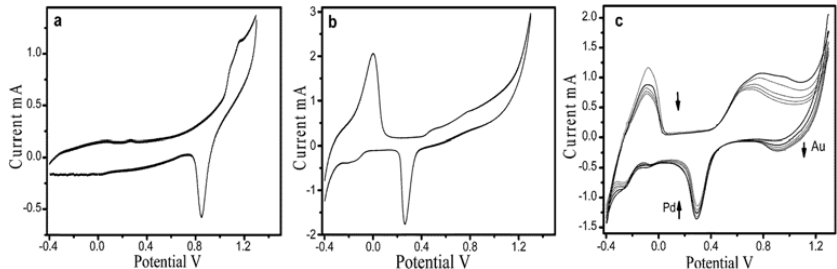
Figure 6. Cyclic voltammograms of graphite rod modified with nanoparticles of ( a ) Au ( b ) Pd ( c )